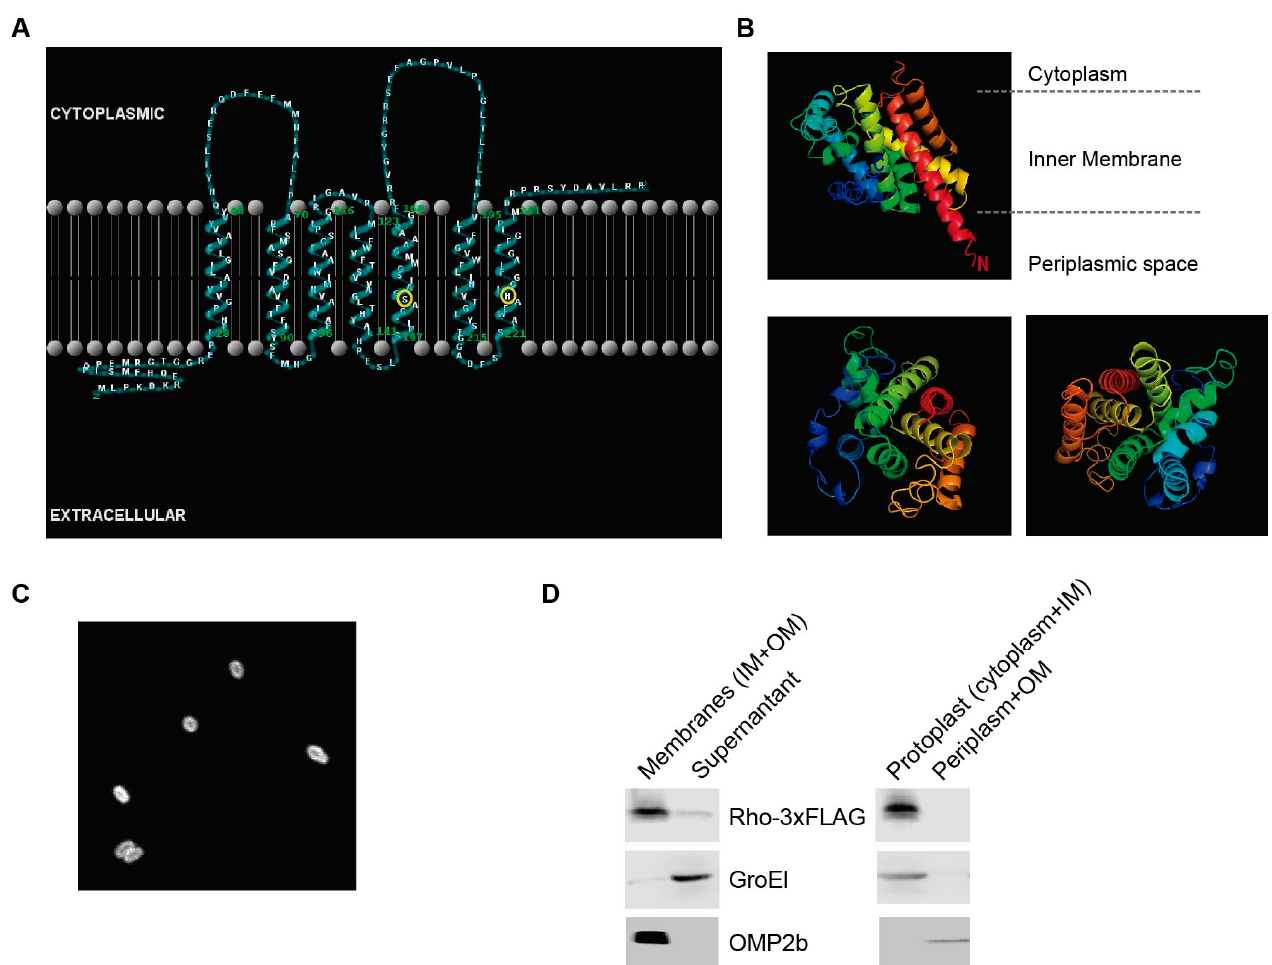
Figure 2. Topology of B. abortus rhomboid. ( A ) Topology model built with TMRPres2D. Rhomboid catalytic residues in TMD5 and TMD7 are circled (yellow). Rhomboid N-terminus is in the periplasm (extracellular) and C-terminus is cytoplasmic. ( B ) Predictive 3D structure of rhomboid by I-TSAAER. ( A ) Colored ribbons indicate transmembrane helices of rhomboid; N denotes the N-terminus; C denotes the C-terminus. Lower left: View from the periplasmic space; Lower right: view from the cytoplasm. Ribbons were colored using the rainbow color scheme implemented in PyMOL. ( C ) Fluorescence confocal microscopy images of B. abortus constitutively expressing Rho_ EYPF fusion protein. ( D ) Subcellular localization of rhomboid protease by Western blot analysis of the indicated fractions. B. abortus pLF_ rho strain (FLAG staining); Omp2b, outer membrane protein 2b; GroEL, cytoplasmic chaperonin. OM: outer membrane; IM: inner membrane. To ascertain rhomboid intramembrane localization, a B. abortus strain